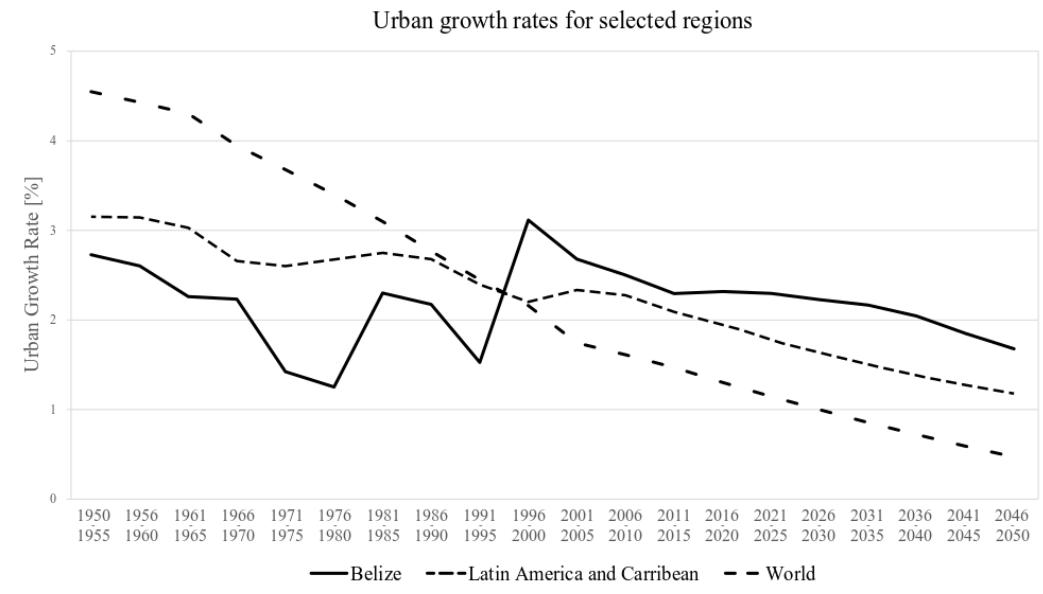
Figure 2. Comparison of measured and prospected urban growth rates for Belize, the Latin America and Caribbean region and the World as based on UN data [1].